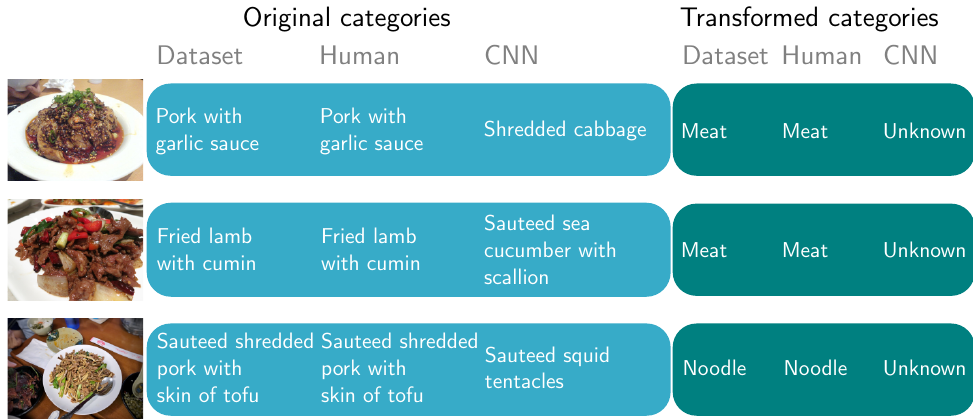
Figure 15. Classification of selected images from VireoFood-172 dataset [58] by ASIA population. When using original categories CNN classification are different from true category. Images are only examples to visually represent a dataset category. They are not part of the dataset. <four-joy meatballs> photo by Yoppy licensed under CC BY 2.0, <pork with garlic sauce> photo by Irrational Cat and <sauteed shredded pork with garlic sprout> photo by Kent Wang licensed under CC BY-SA 2.0.